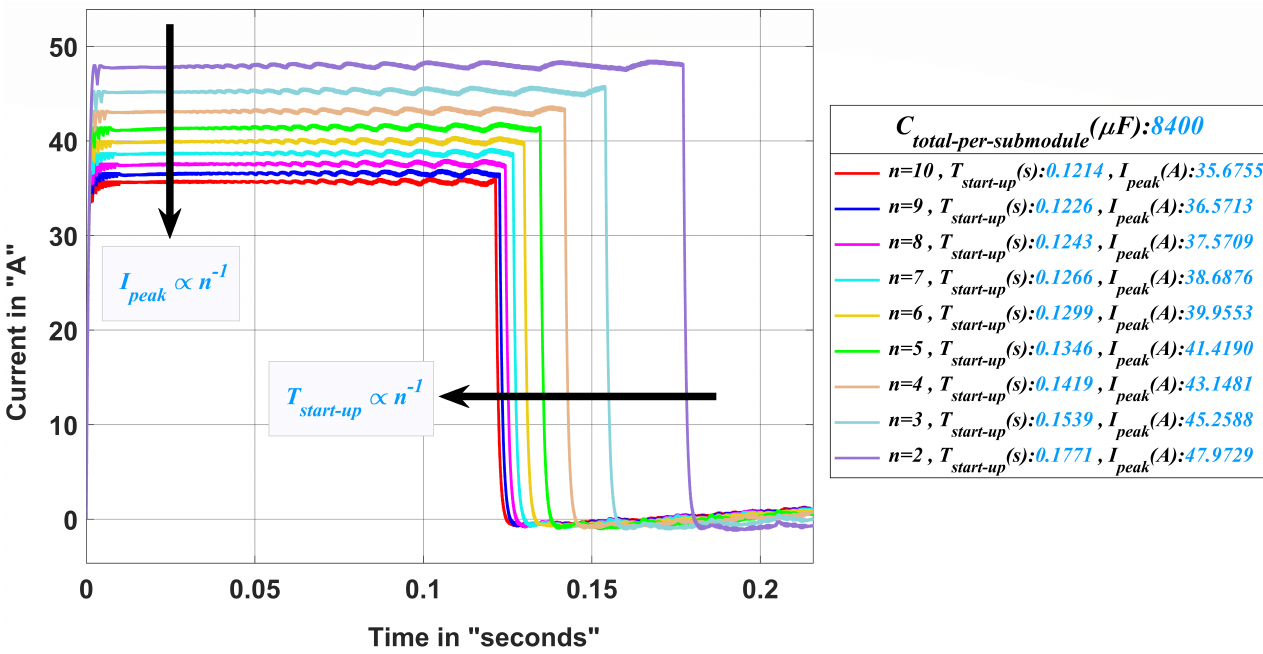
Figure 7. The proposed start-up precharging method applied on a single-phase MMC having the capacitor bank topology while varying the number of stages of the capacitor bank per